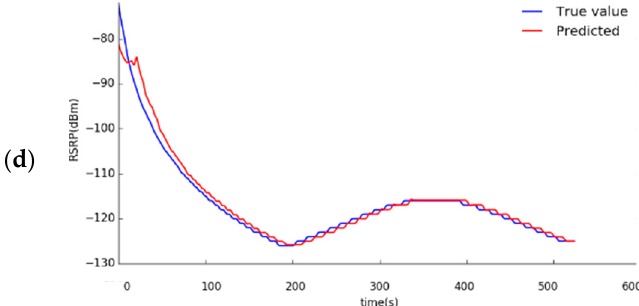
Figure 17. Predicted RSRP results for the next 6 s: ( a ) MLP, ( b ) CNN, ( c ) RNN, ( d ) LSTM.